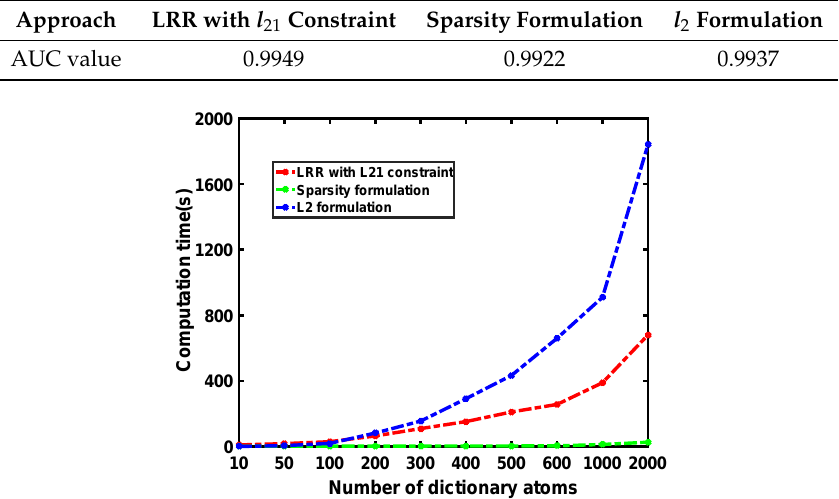
Figure 24. Detection maps obtained by different approaches for the San Diego dataset. ( a ) LRR with l 21 constraint; ( b ) Sparsity formulation; ( c ) l 2 formulation. Table 5. AUC values obtained by different approaches for the San Diego dataset.